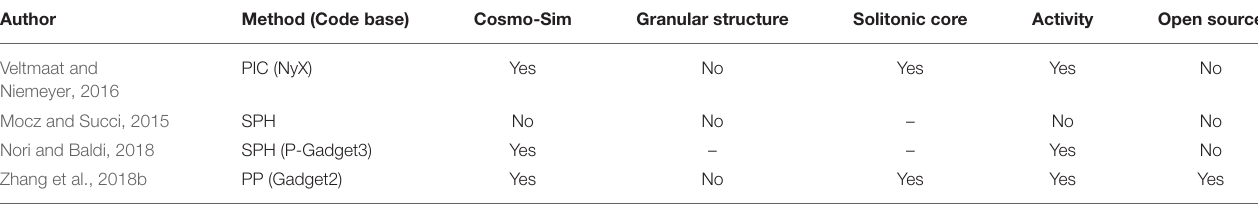
TABLE 1 | Summary of the Lagriangian based simulation codes for FDM model (Madelung